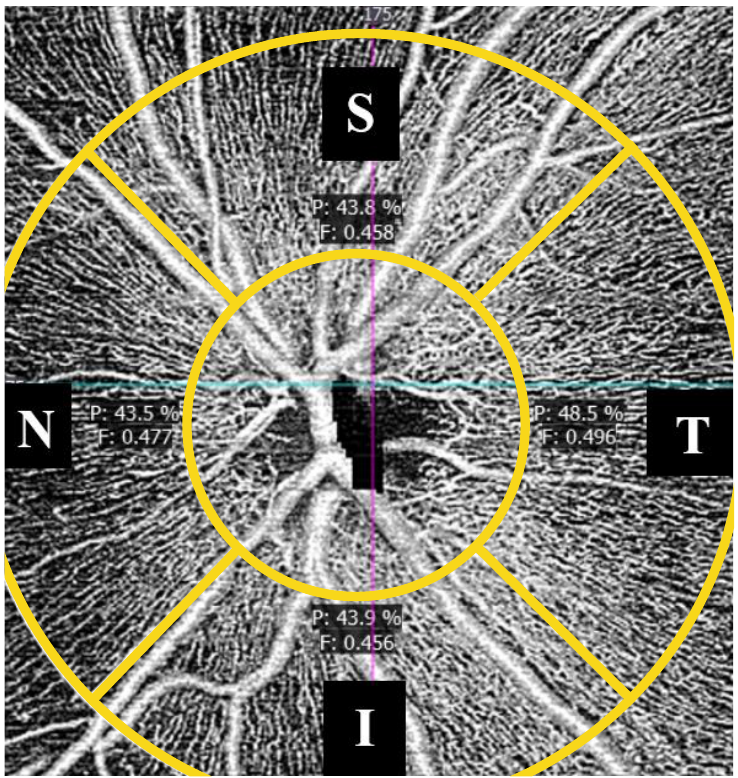
Figure 5. Peripapillary microvascularization map. Perfusion density (P) is indicated in percentage (%). Flux index (F) is unitless. S = superior, I = inferior, N = nasal, T = temporal.